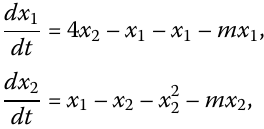
Figure 8 Numeric simulations of the first component x 1 ( t ) of system (5.6), with m = 0.1,0.3,0.5, where black curve is the solution of m = 0.1, blue curve is the solution of m = 0.3, and red curve is the solution of m = 0.5, and ( x 1 (0), x 2 (0)) =